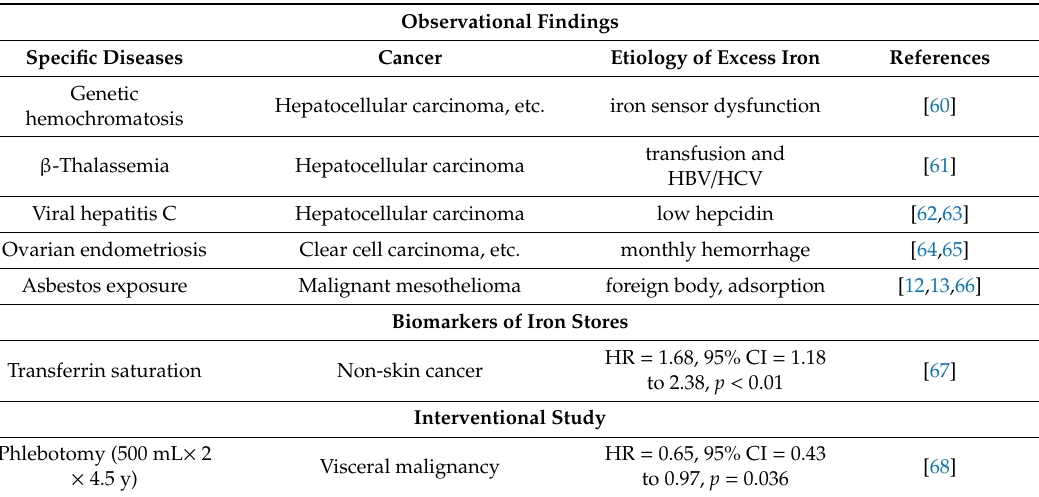
Table 1. Representative human facts on the association of iron and carcinogenesis.